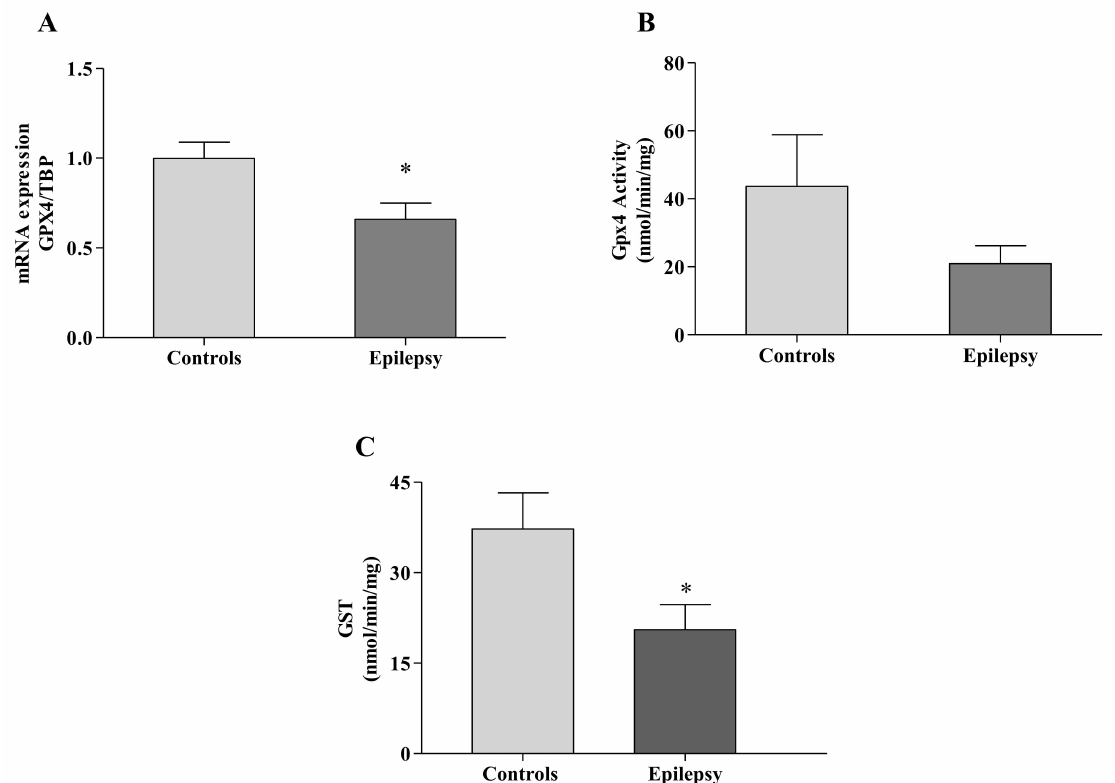
Figure 3. GPX4 and GST in blood of n = 83 children with epilepsy and n = 44 controls. Real-time PCR analysis ( A ) and enzymatic activity ( B ) of GPX4 in leukocytes of children with epilepsy. GST activity ( C ) was measured as reported in Methods. Enzyme activities are expressed as nmol/min/mg protein. Values are expressed as median ± SEM. Statistical significance is defined as * p < 0.05, respect to